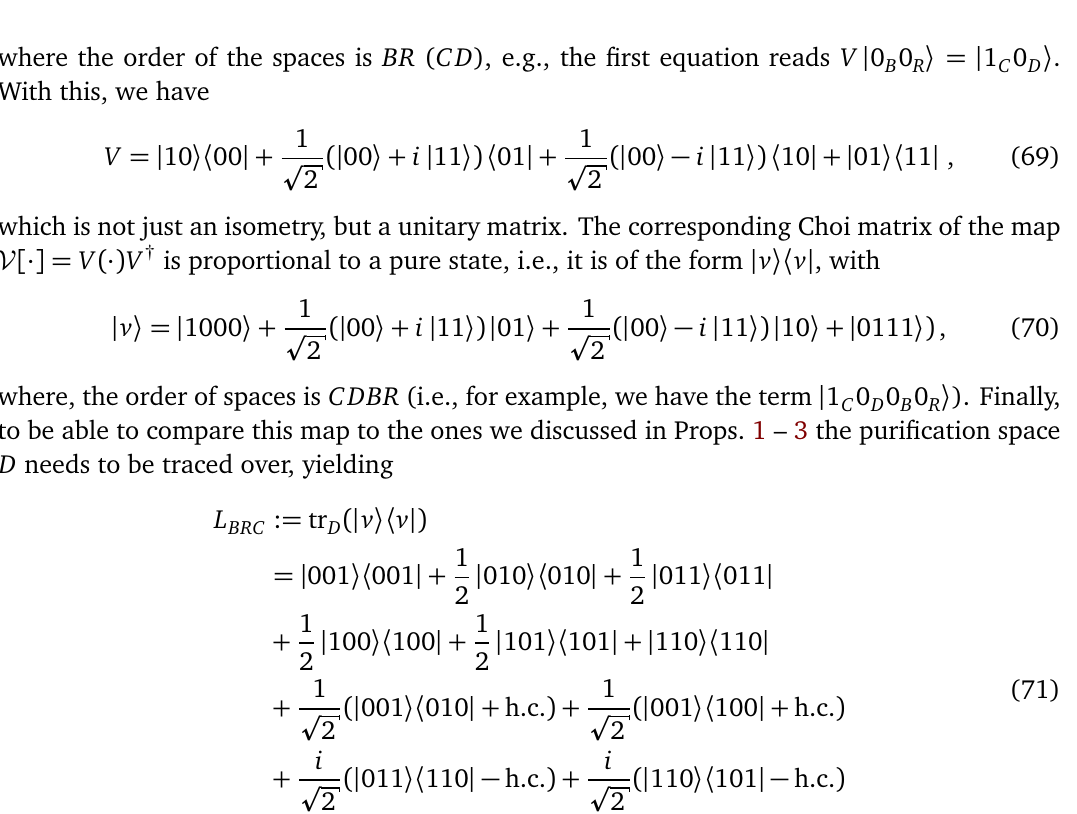
. See text for further ABC